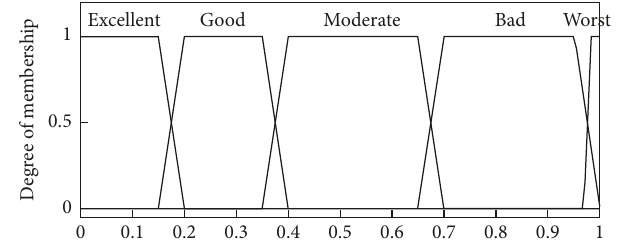
Figure 11: Output variable MF-health index.